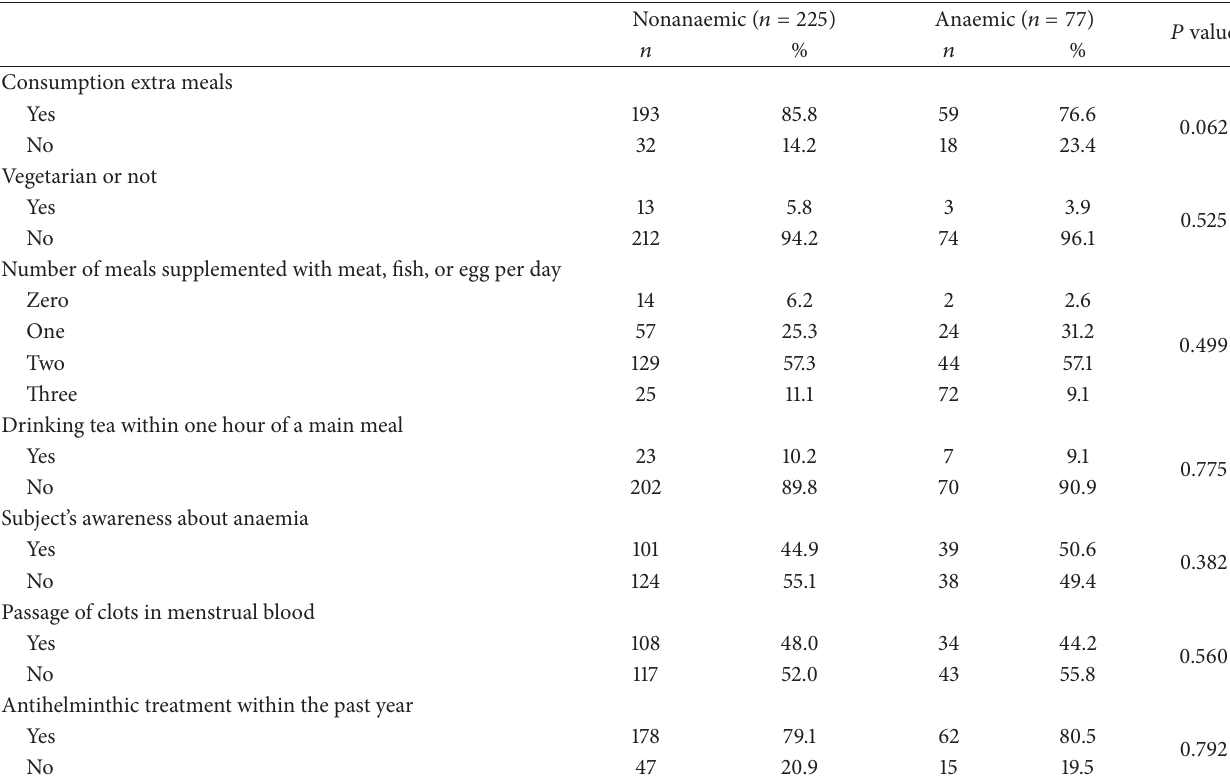
Table 3: Distribution of nonanaemic and anaemic subjects according to dietary habits and selected medical